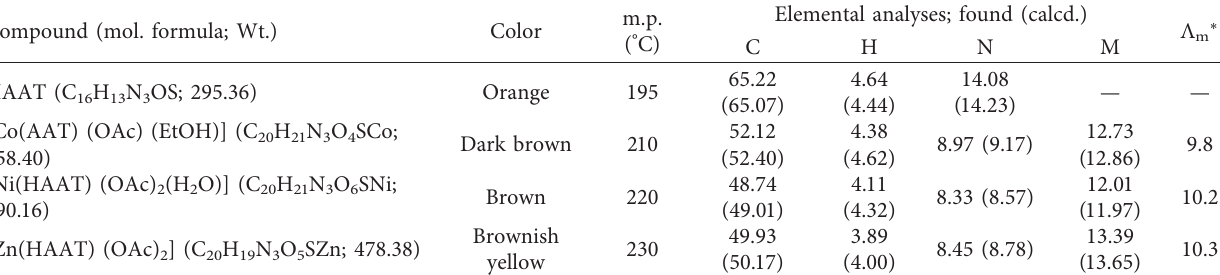
Table 1: Analytical and physical data of HAAT and its complexes.